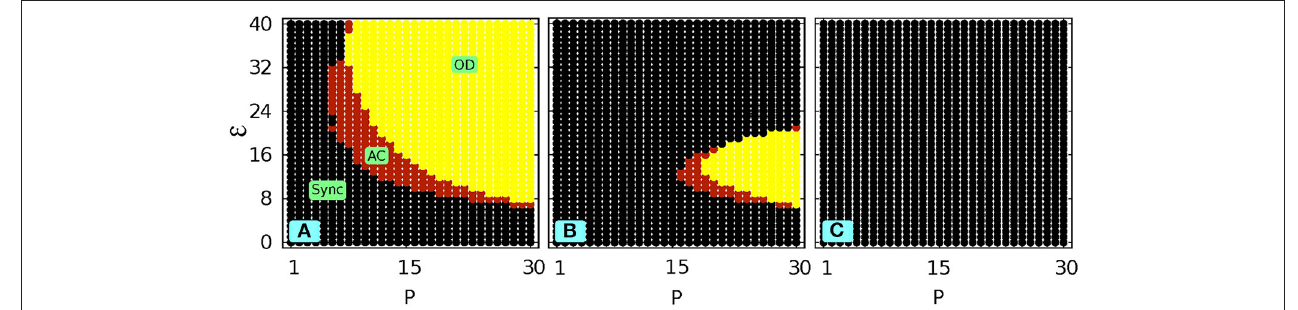
FIGURE 3 | With local low-pass filtering: Phase diagram in the P vs ε space ( N for α =